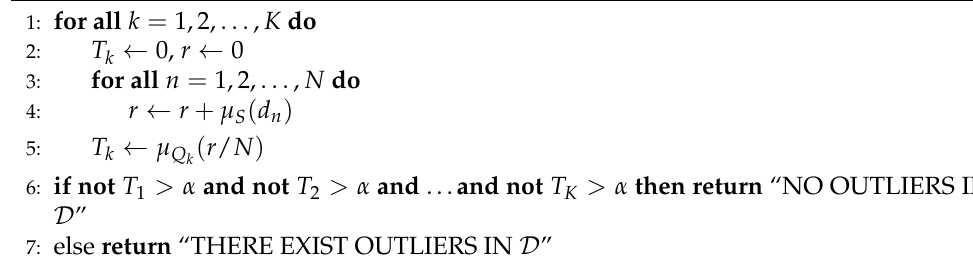
Algorithm 1 Detecting outliers via the first form of linguistically quantified statement.